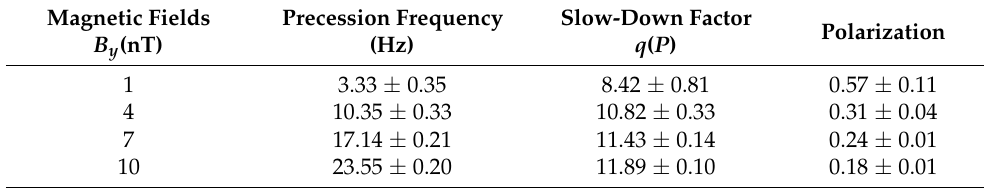
Table 3. P x response measurement results under different magnetic fields.